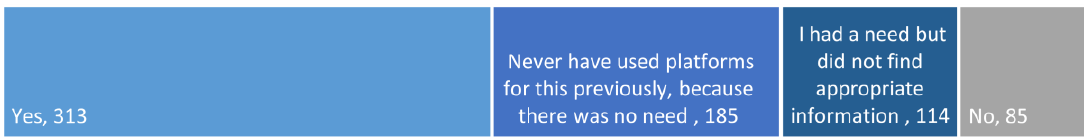
Figure 9. The respondents’ answers on question that determine the possibility to find external support with the help of the Internet platforms (number of SMEs who answered)